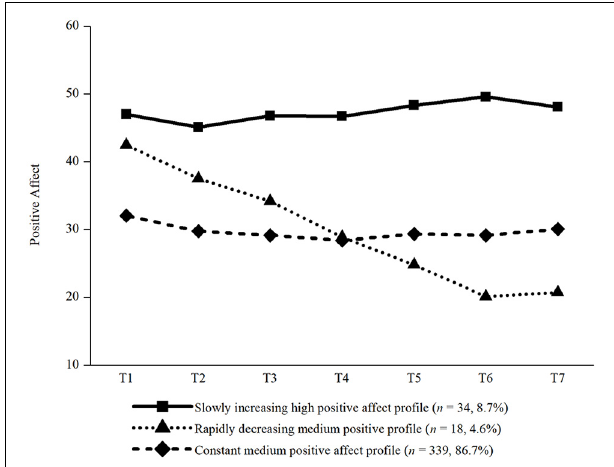
FIGURE 2 | The three trajectories of positive affect. N = 391, T1 = Monday, T2 = Tuesday, T3 = Wednesday, T4 = Thursday, T5 = Friday, T6 = Saturday, T7 = Sunday.